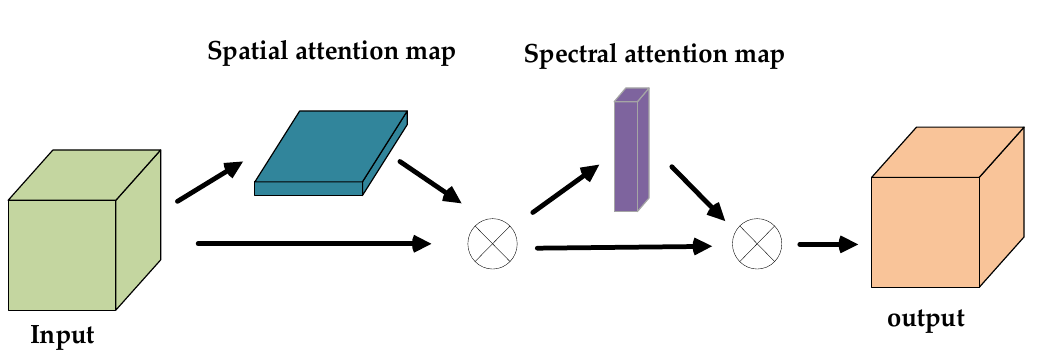
Figure 10. Spatial–spectral attention module.